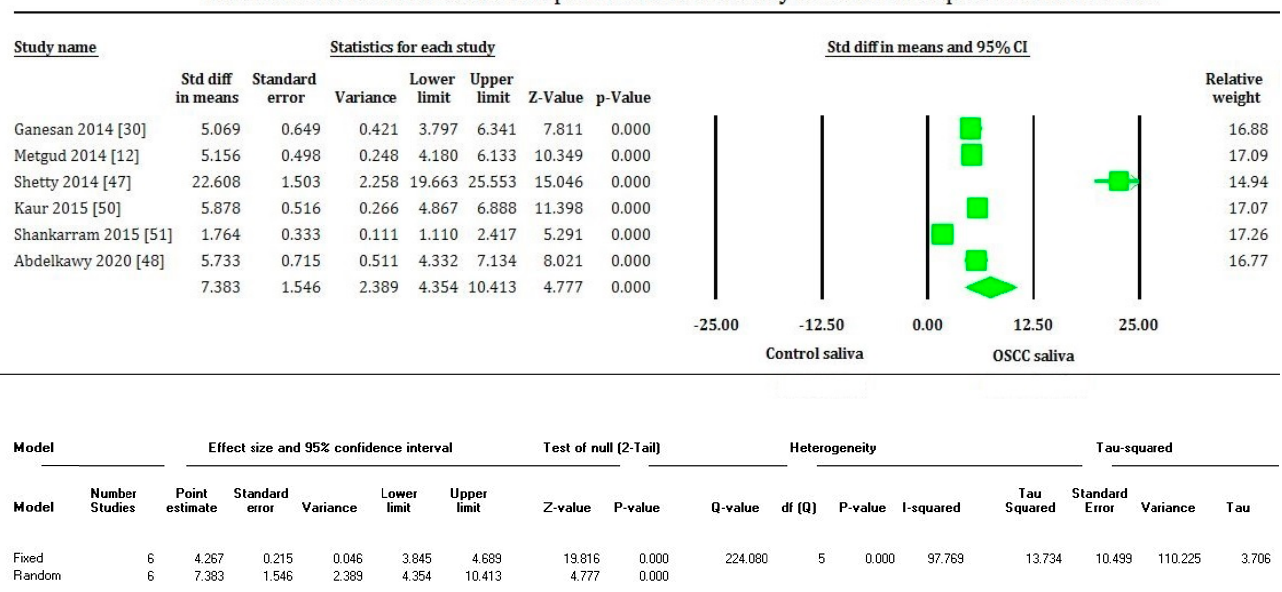
Figure 5. Forest plot shows mean difference estimates with 95% confidence intervals representing differences in tissue levels of MDA between oral squamous cell carcinoma group and healthy controls. The meta-analysis presented high heterogeneity, reflected by the I 2 values 92.648, 86.785, 97.769, and 64.792 of Figures 2–4, respectively. The different methodologies uti- lized to measure MDA levels could be the reason for the high heterogeneity. 4. Discussion Lipid peroxidation is a sequential reaction providing a constant supply of free radi- cals that initiate further peroxidation and free radicals accumulation, resulting in OS [77].